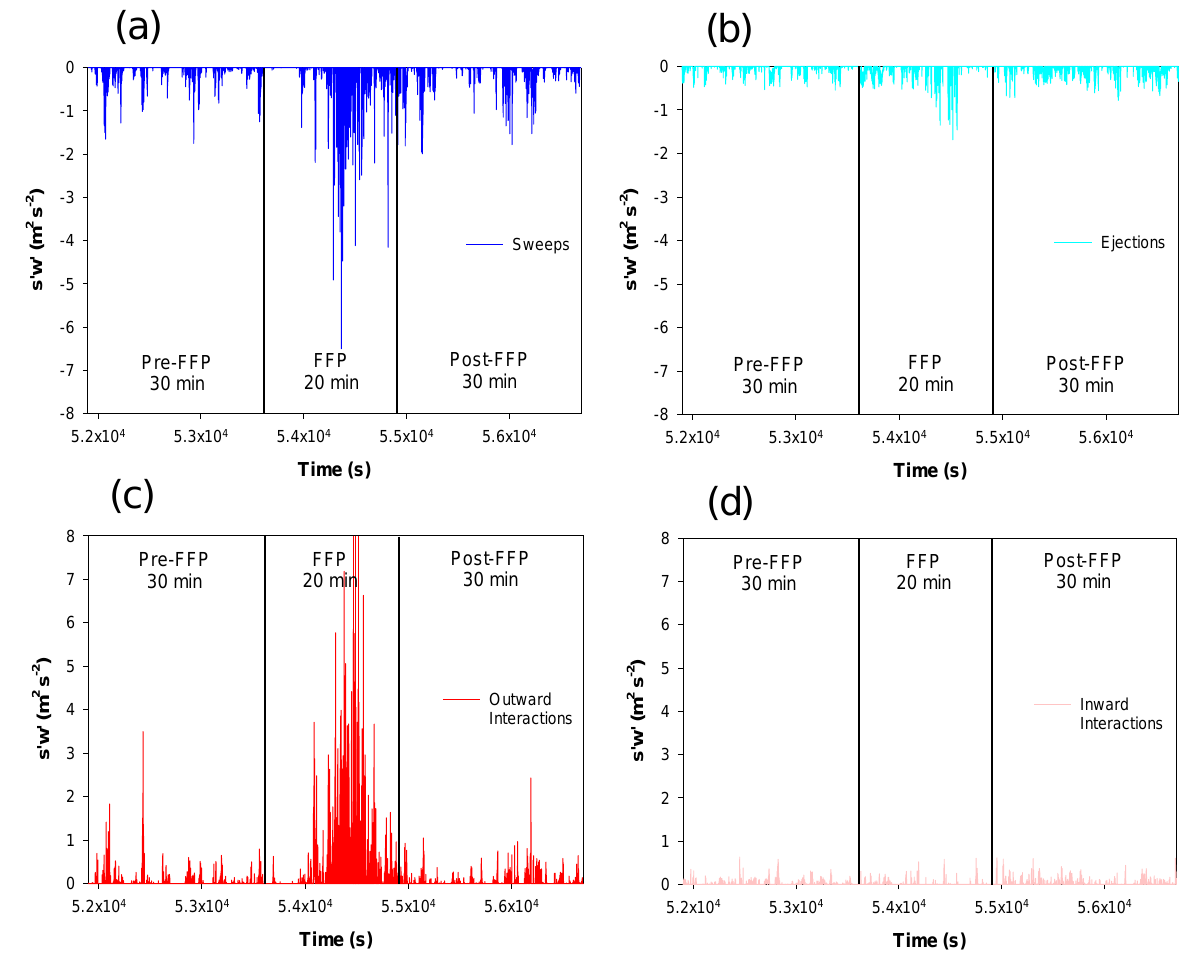
Figure 9. Time series (10-Hz) of the vertical turbulent momentum fluxes (s (cid:48) w (cid:48) ) attributed to ( a ) sweeps, ( b ) ejections, ( c ) outward interactions, and ( d ) inward interactions during the pre-FFP, FFP, and post-FFP periods at 3 m AGL at the south